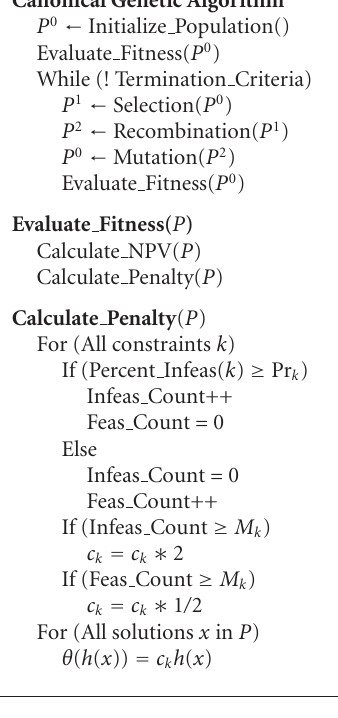
Algorithm 1: Pseudocode for the genetic algorithm, plus fitness and penalty evaluation functions. The canonical genetic